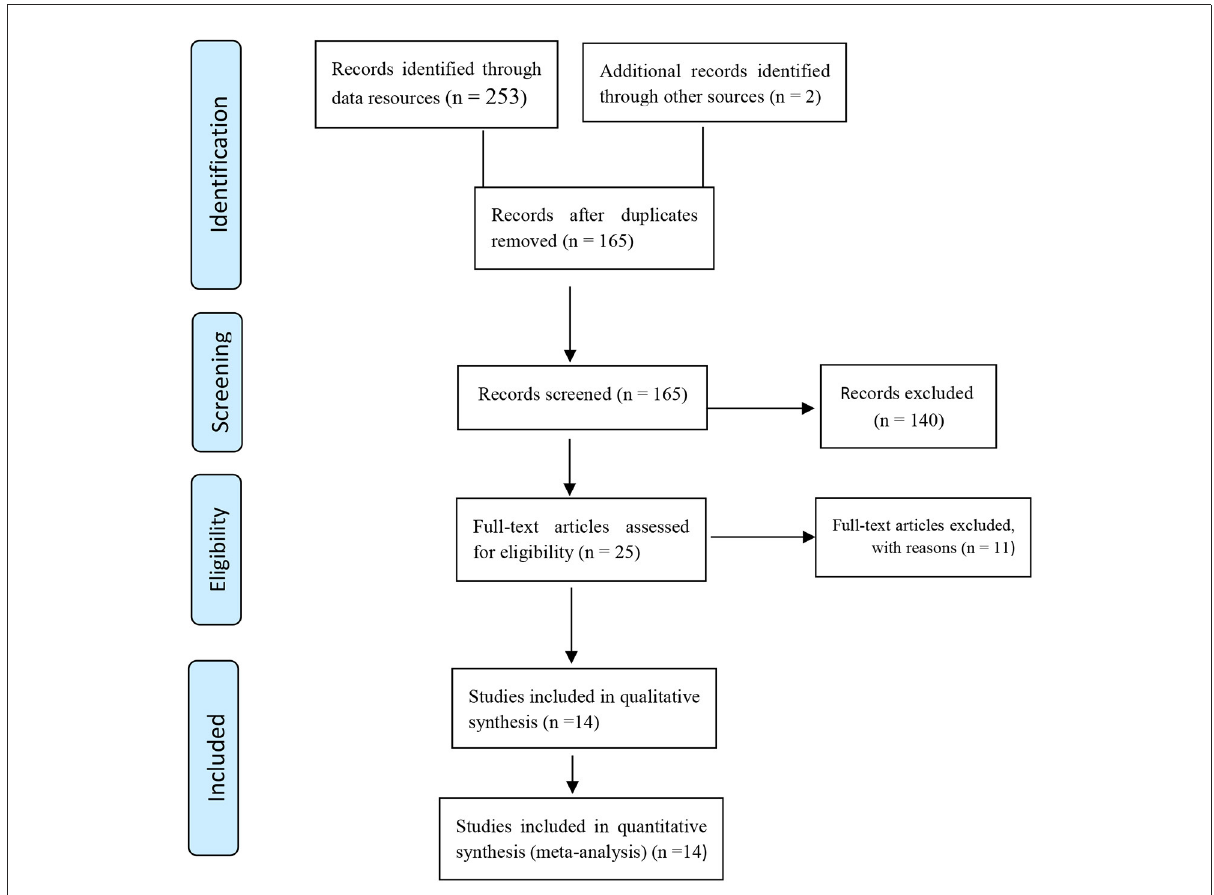
FIGURE1 Flowchart of the selection of studies based on